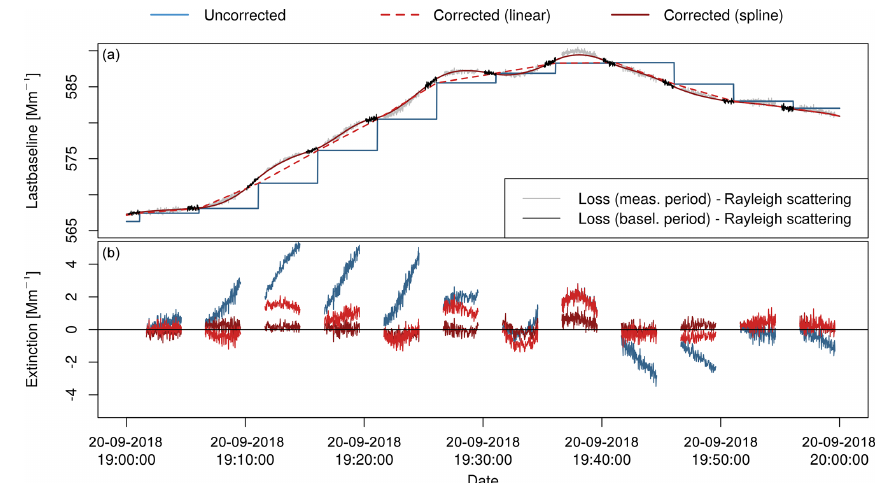
Figure 3. Time series of “lastbaseline” (a) and the resulting extinction values (b) for the uncorrected (blue) and corrected methods, using linear interpolation (orange) and cubic smoothing splines (red), for CAPS-blue (450nm) measuring particle-free ambient air. In (a) the loss signal subtracted by the Rayleigh scattering for the measurement (grey) and baseline period (black) are additionally shown. The resulting extinction value in (b) is the direct consequence of the deviation between these values the used baseline.